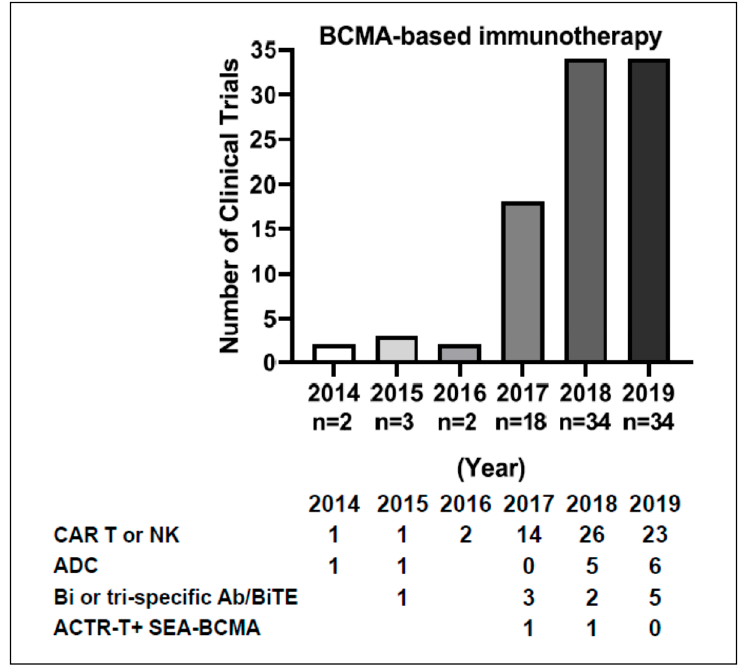
Figure 3. The annual number of clinical trials of BCMA ‐ targeting immunotherapy in MM since 2014. The searching word is ʺ myeloma ʺ . The “Year” indicates the first post year of the trial on Clinicaltrial.gov. Shown below are the numbers of trials in various immunotherapeutic modalities each year. For example, there are 23 CAR T, 6 ADC, and 5 Bi/Tri ‐ specific Ab/BiTE trials in 2019. Every effort has been made to obtain reliable data from multiple sources including http://clinicaltrials.gov/, company, and other web sites, but accuracy cannot be fully guaranteed to date.